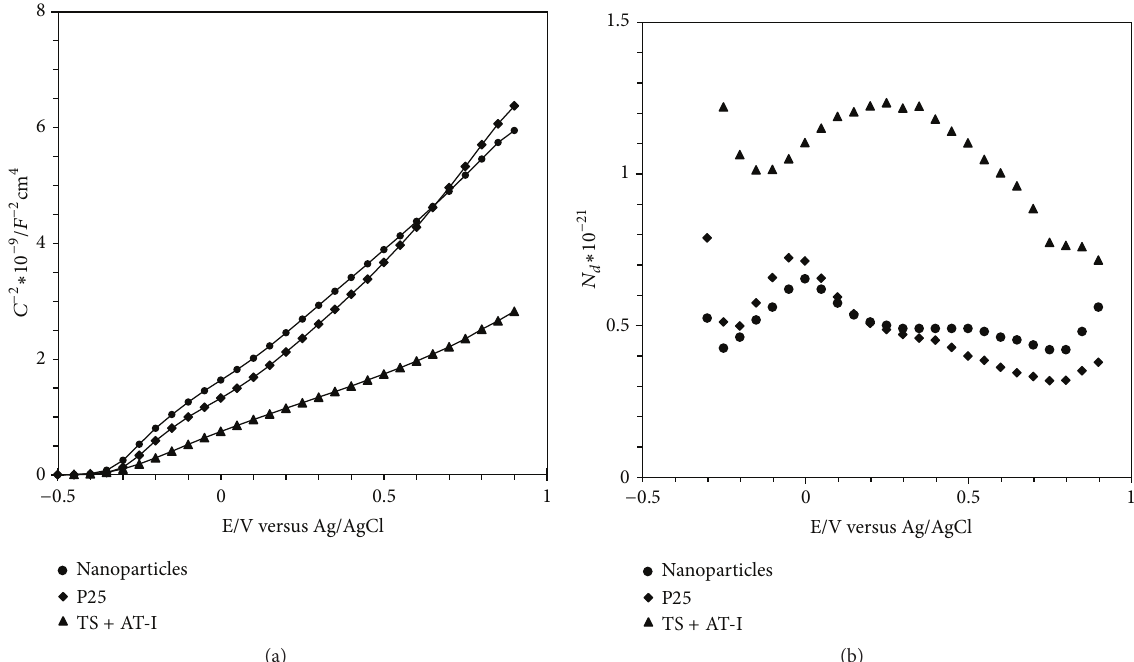
Figure 4: (a) The Mott-Schottky plots for different surfaces. The response for the TS + 8nm and TS + 22 nm surfaces is the same and is shown as one graph. (b) The number of charge